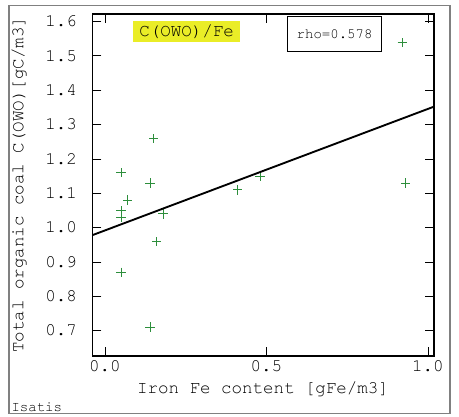
Fig. 14. Diagram correlation of temperature  C [degrees] and ammonium ion  NH content [g  NH /m 3 ] in underground water, 4 4 with the marked regression line Y / X in the area of water intake in the region of Kłodzko (14 wells)